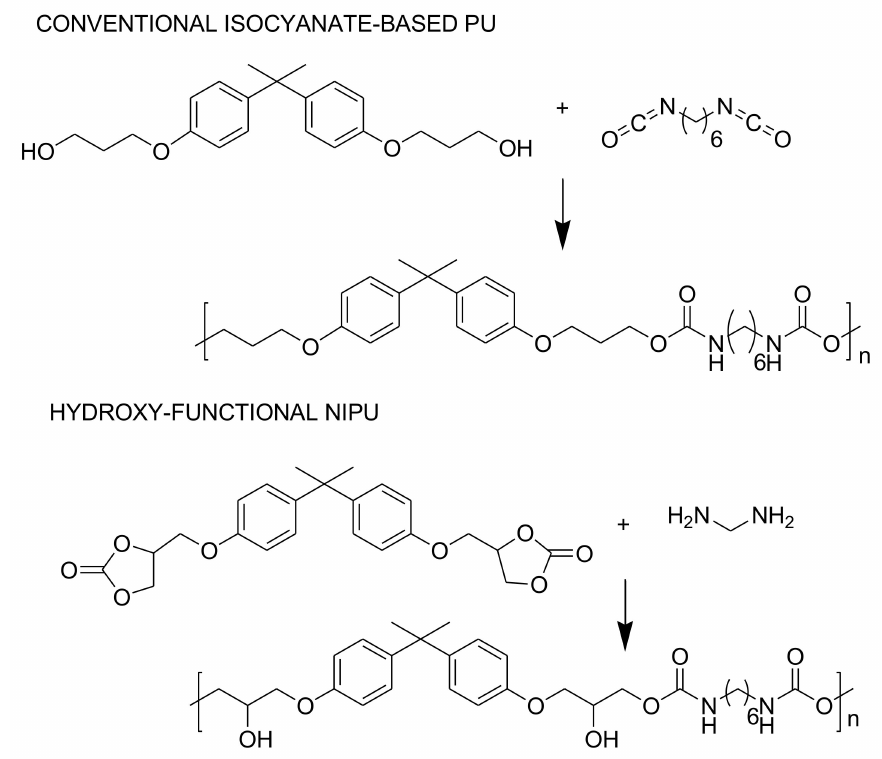
Figure 5. The conventional method of polyurethane synthesis in comparison with a route to hydroxyl- functional NIPUs